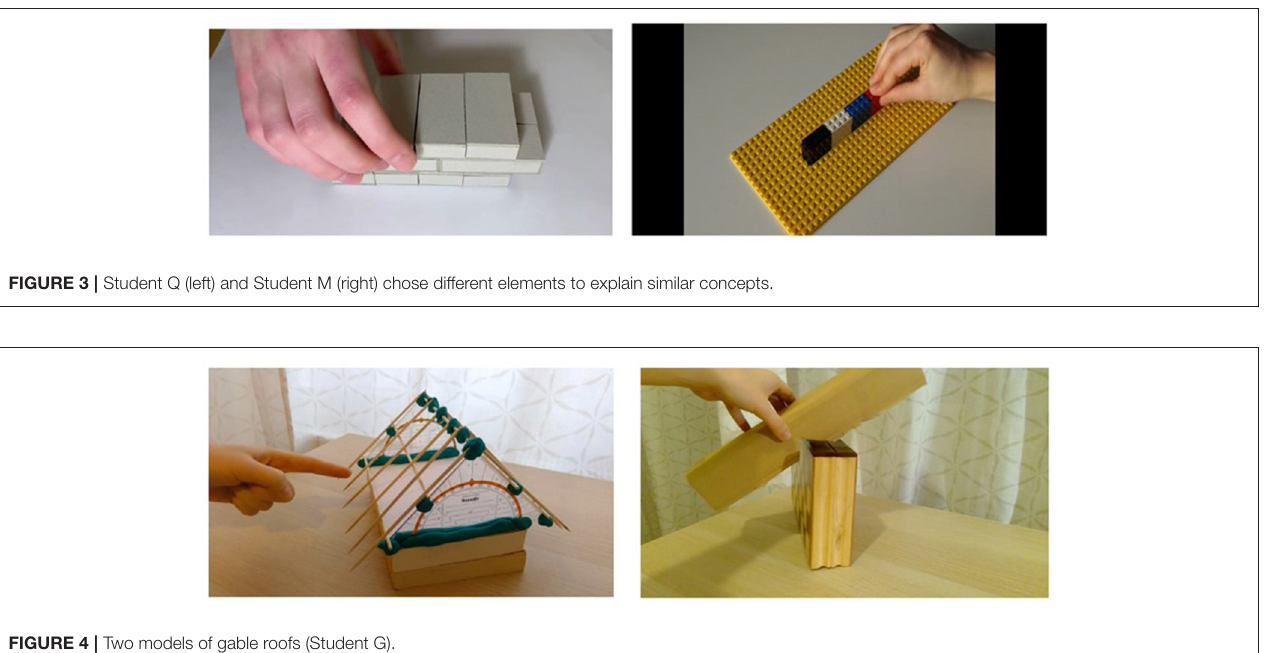
FIGURE 4 | Two models of gable roofs (Student G).